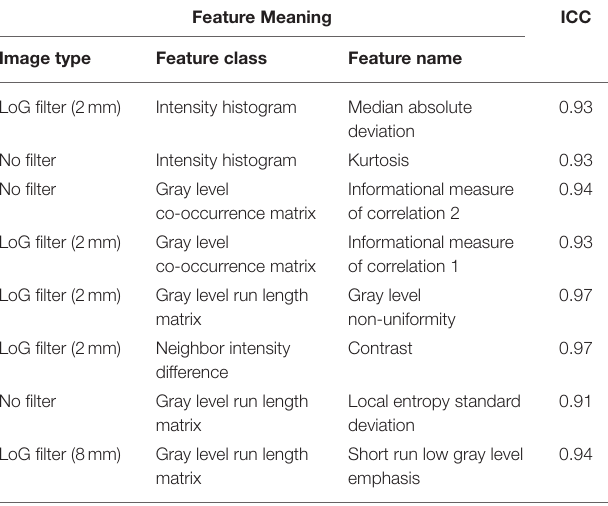
TABLE 2 | Selected texture features for random forest